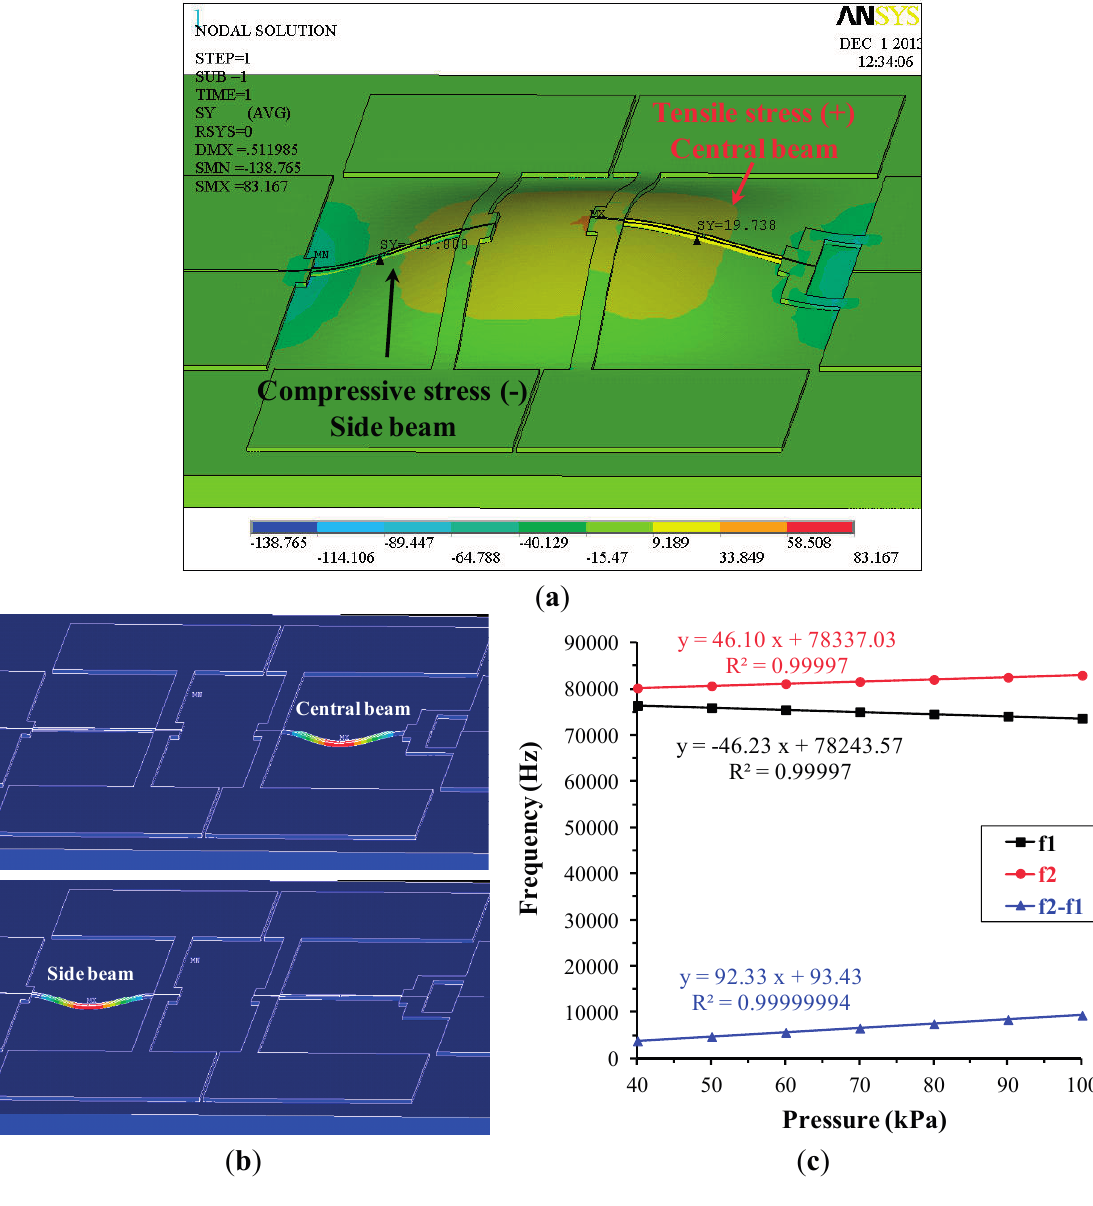
Figure 3. Simulation results. ( a ) The stress contour along the axial direction of the resonant beams under an applied pressure of 100 kPa. Positive stress (tensile) was induced in the central beam, while negative stress (compressive) was observed in the side beam; ( b ) Maximal displacements of the two resonant beams in the first order lateral vibration mode; ( c ) Simulated resonant frequencies of the two resonant beams as a function of applied